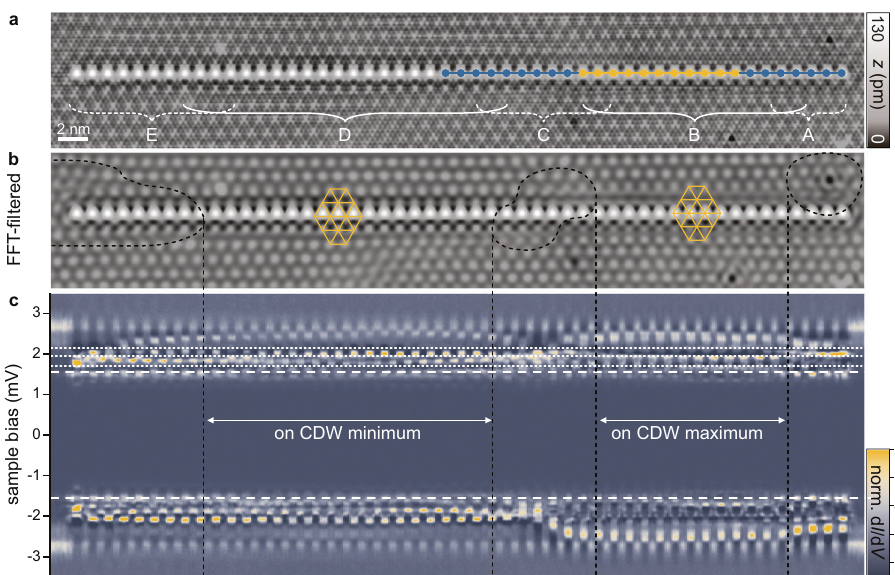
Fig. 6 YSR bands across different domains of the CDW. a STM topography (constant-current mode with set point 100 pA, 10 mV) of the 51-atom chain. The position of the former 11 (27)-atom chain (Figs. 4h and 5) is indicated in yellow (blue). Different sections of the chain are labeled with A – E. Sections A and B are identical to Fig. 5. b To remove the atomic corrugation of the STM image a was FFT- fi ltered. Dashed lines encircle the most pronounced CDW distortions in the background. The yellow grids indicate the CDW and the positions of atoms within the chain relative to the CDW: crossings of the lines lie on CDW maxima, upwards pointing triangles on CDW minima. c Stacked constant-height d I /d V spectra (normalized) recorded along a line across the 51-atom chain (set point 700 pA, 5 mV with a modulation of 15 μ V). The tip gap Δ tip ≈ 1.55 meV is indicated by dashed lines. The dotted lines are located at the same energies as in Fig.